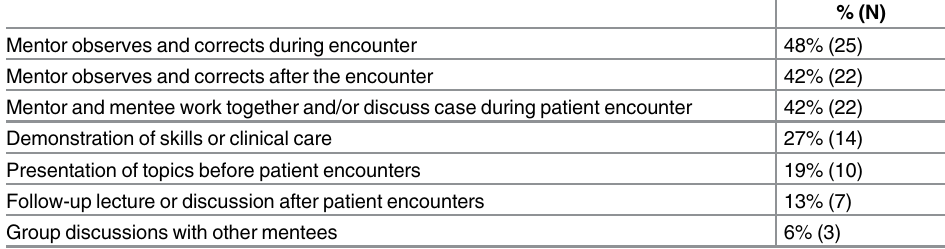
Table 4. Preferred Style of Mentorship (N = 52).